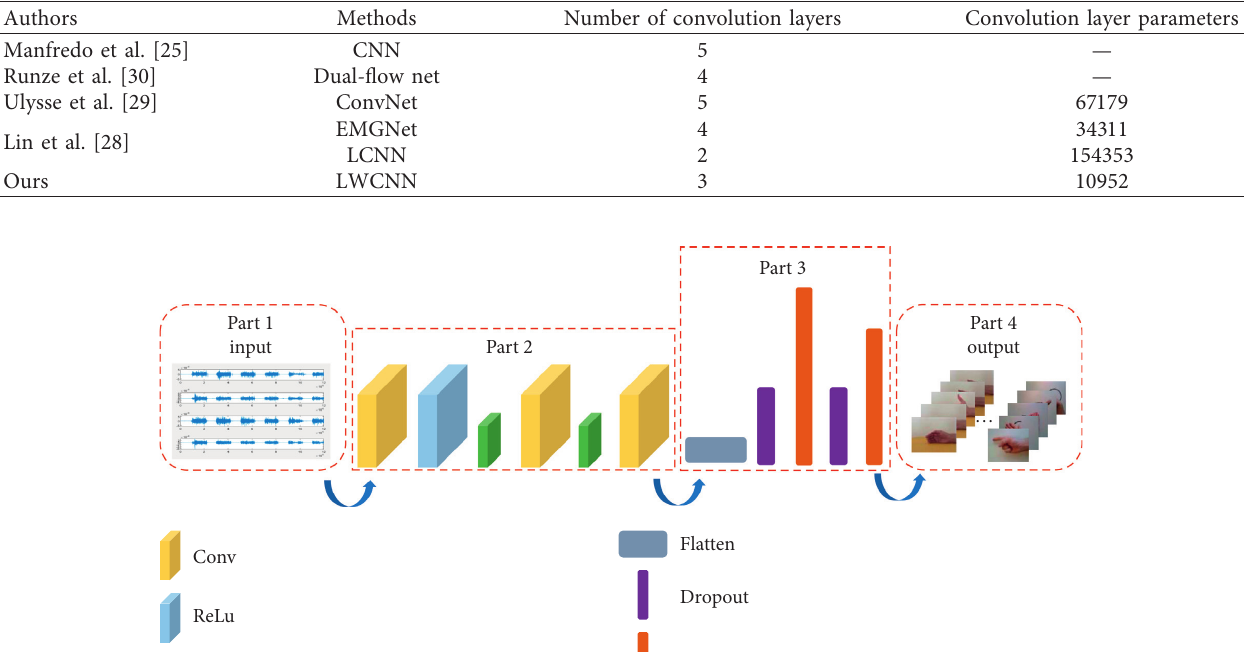
Table 1: Various model parameters based on EMG pattern recognition.